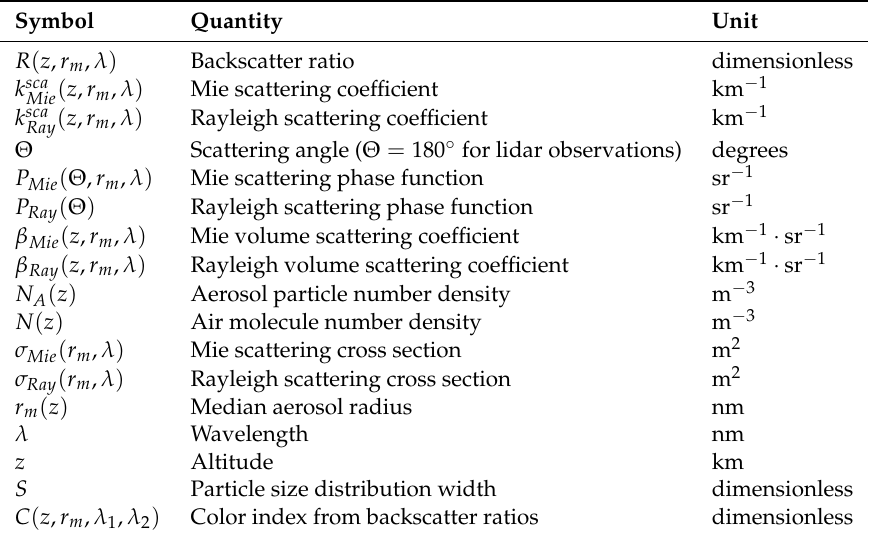
Table 1. Symbols used throughout the